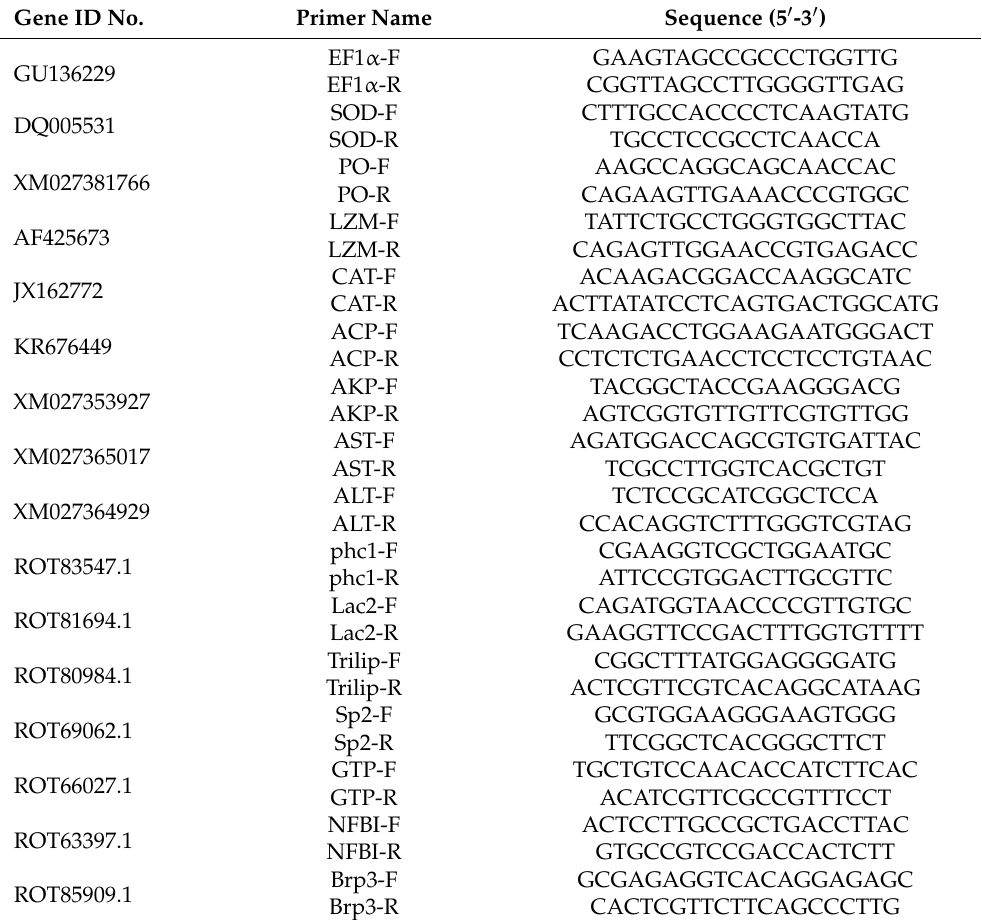
Table 3. Primers used for